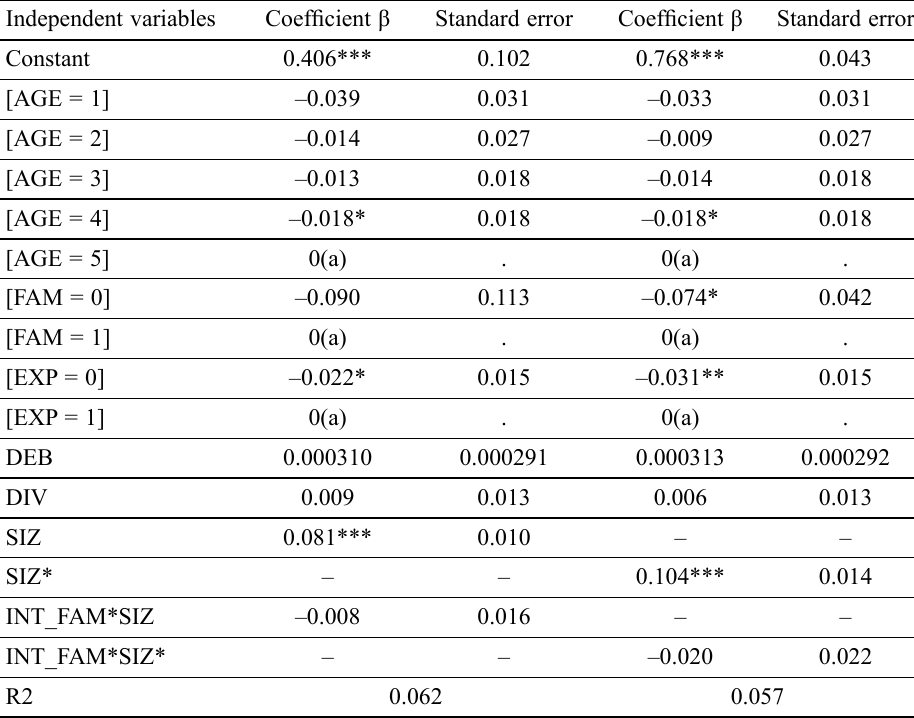
Table 9. Model 4. Dependent variable